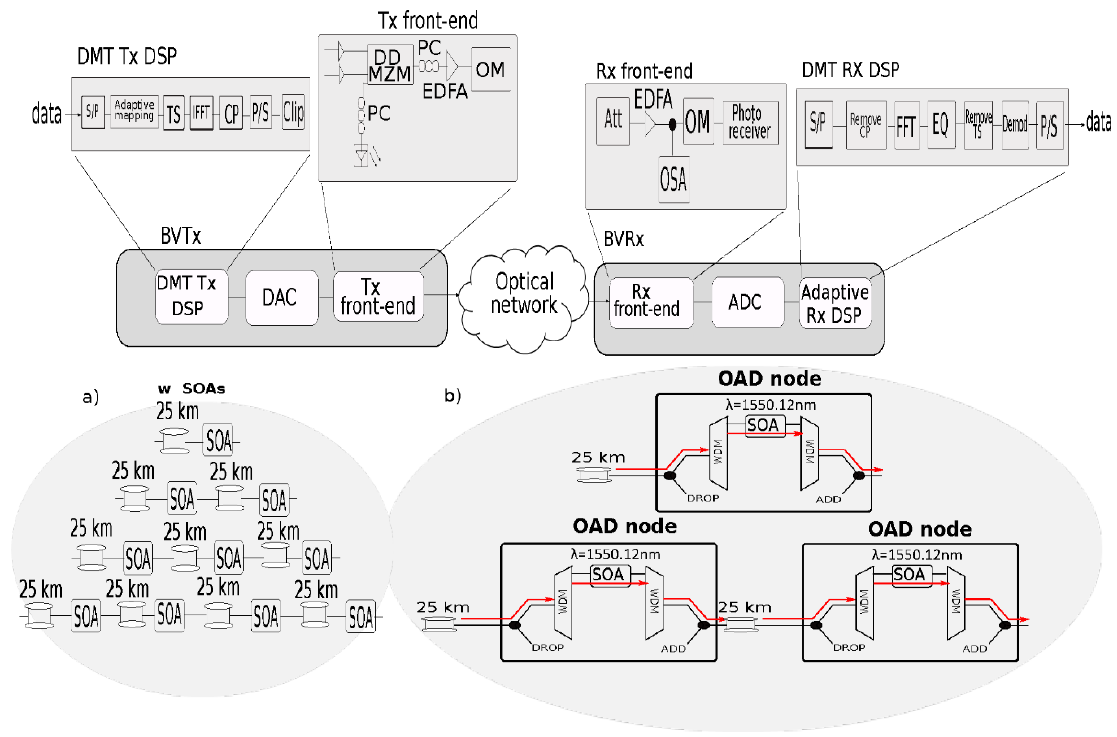
Figure 3. BVT architecture and experimental setup. OM: optical power monitoring, Att: Attenuator, OSA: Optical Spectrum Analyzer, EQ: Equalizer. The different analyzed scenarios for the optical metro network are indicated: ( a ) with SOAs and 25 km Single Standard Mode Fiber (SSMF) spools, and ( b ) with OAD nodes based on SOAs.